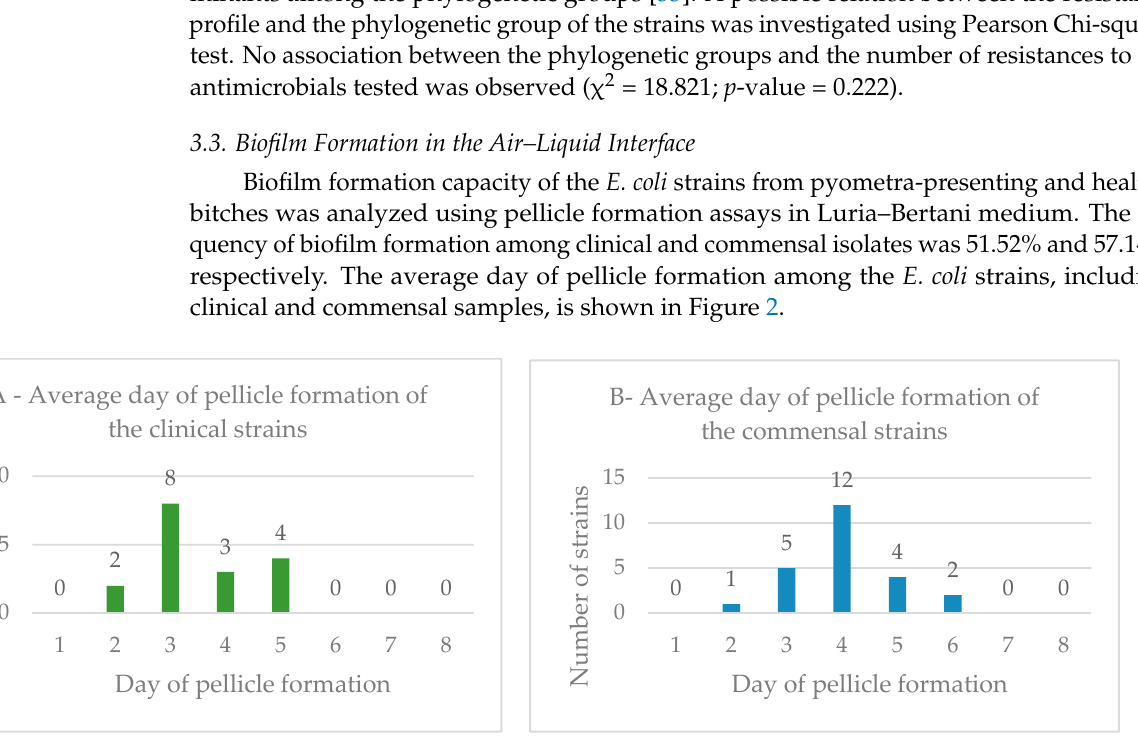
Figure 2. ( A ) Average day of pellicle formation in the air–liquid interface for the Escherichia coli clinical strains; ( B ) Average day of pellicle formation in the air–liquid interface for the Escherichia coli commensal strains from canines.